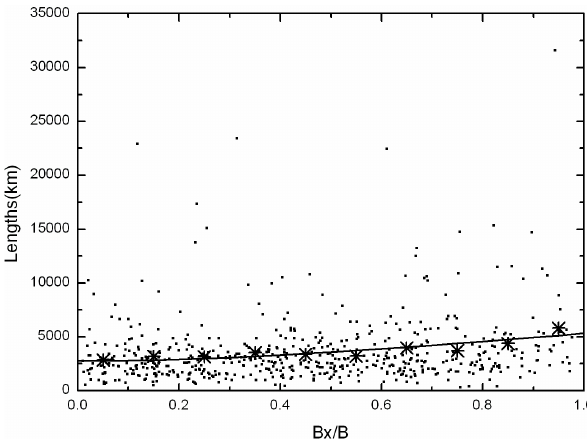
Fig. 2. Magnetic hole duration versus the orientation of the mag- netic field deduced from Cluster-C1 data. The orientation of the magnetic field is represented by the value of the x component of the magnetic field at the beginning of the mag- netic holes. Small crosses represent the 567LMHs selected for this study. asterisks are the medians for each 0.1 fitting are presented based on the asterisks.